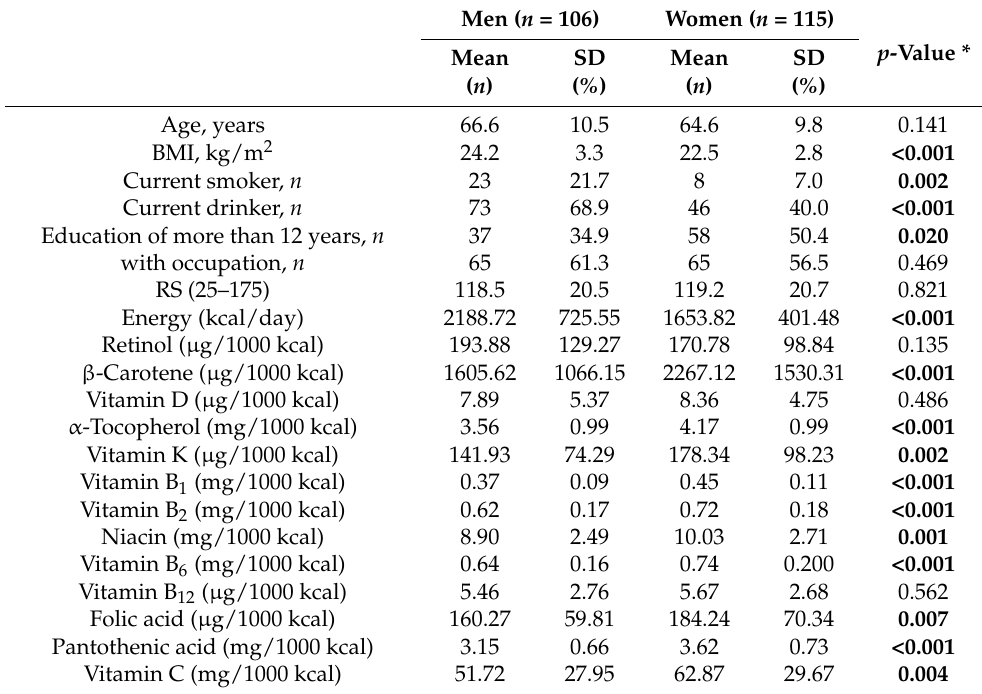
Table 1. Participant characteristics according to